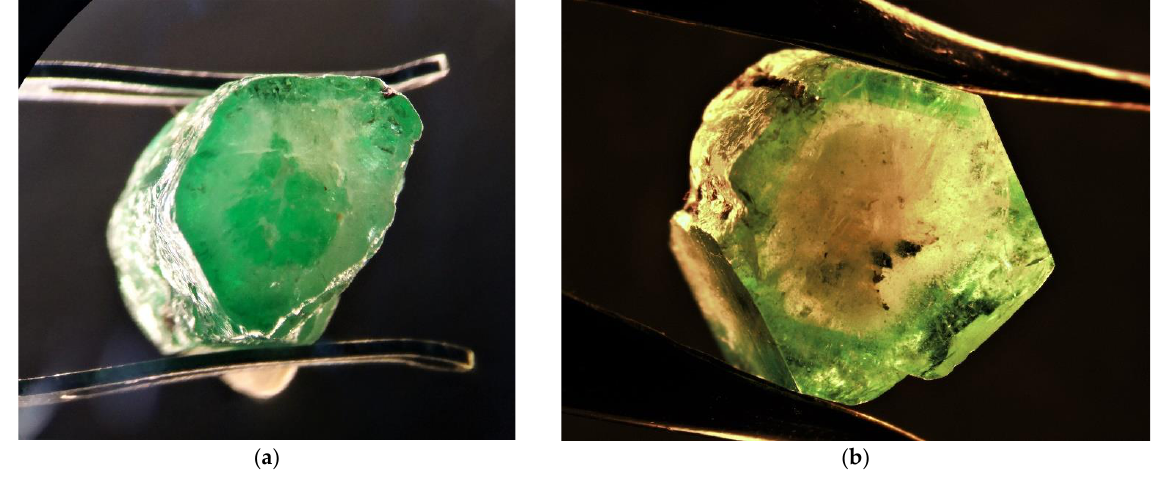
Figure 4. ( a ) Sample 94-5: Hexagonal color zones with green, white, and light green from the middle to the rim; ( b ) Sample 94-6: Hexagonal color zones with a white core and green at the rim. Field of view 20 mm.